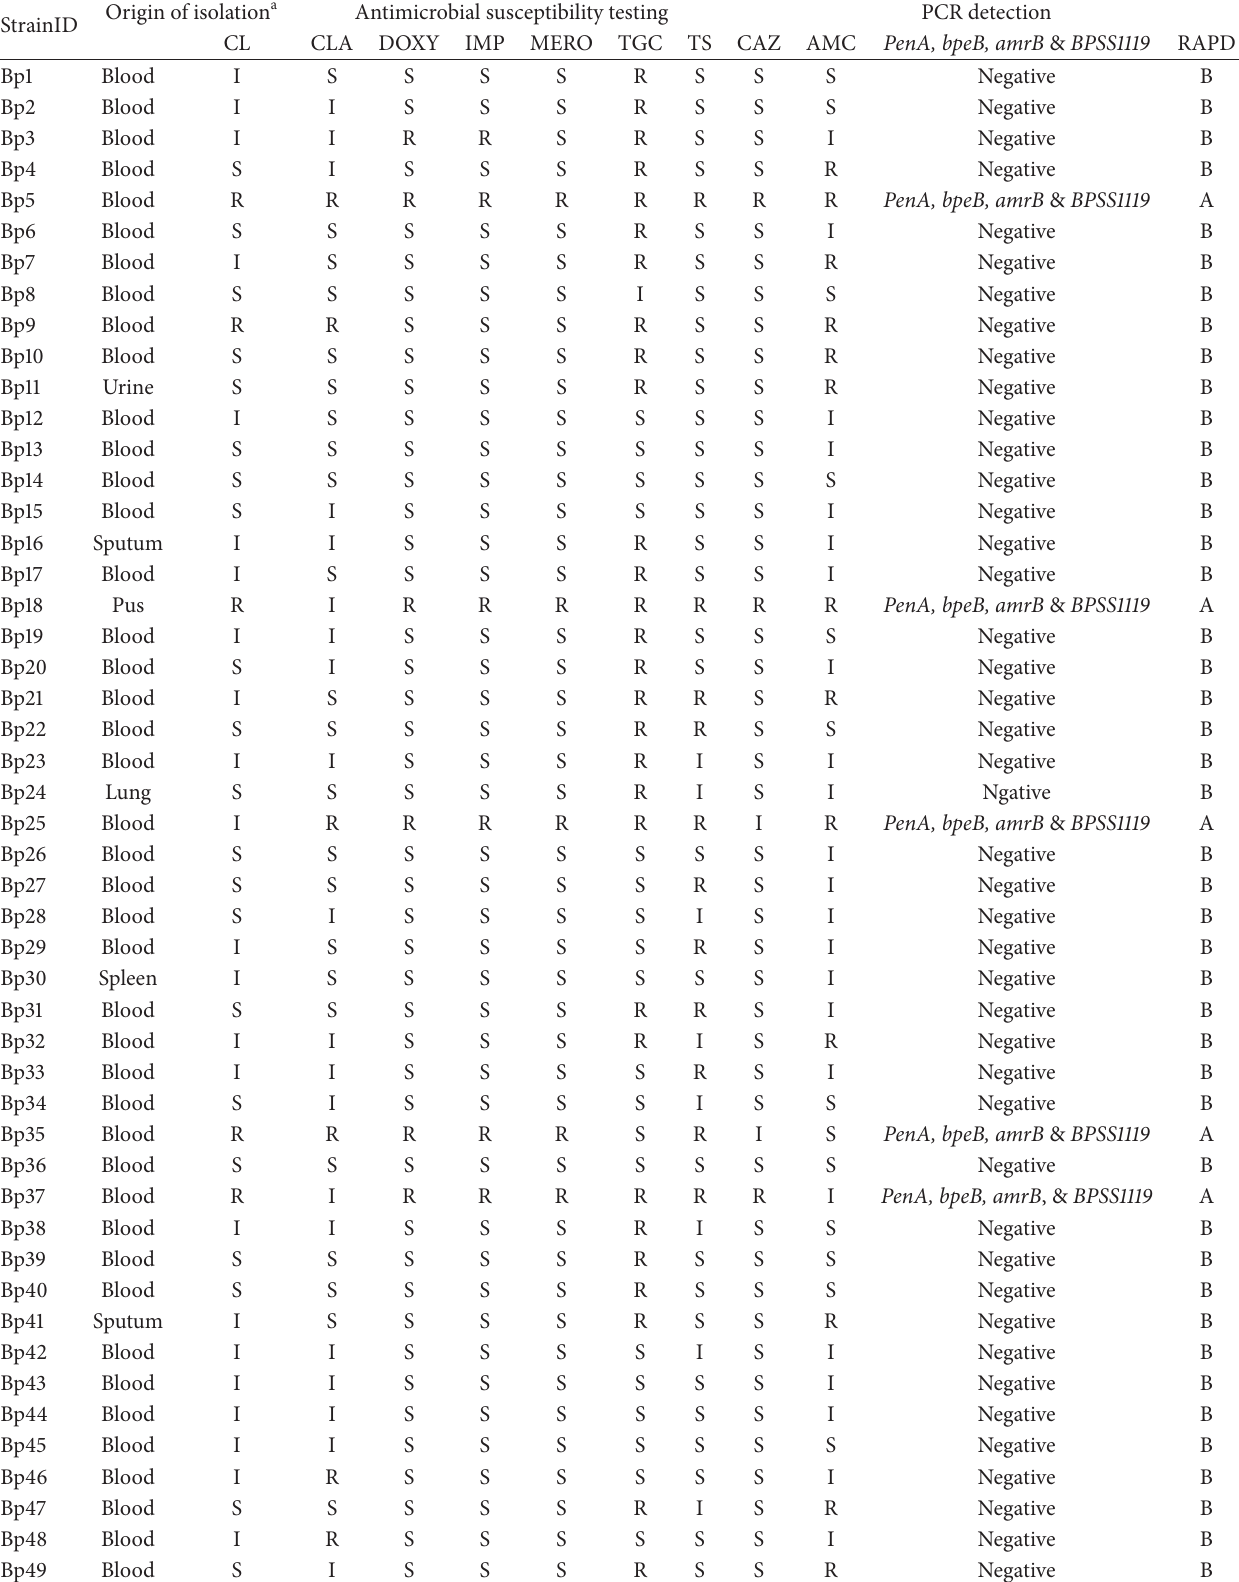
Table 2: Origin, resistogram (disk diffusion), and RAPD of 81 B. pseudomallei isolates and a B. thailandensis isolate.